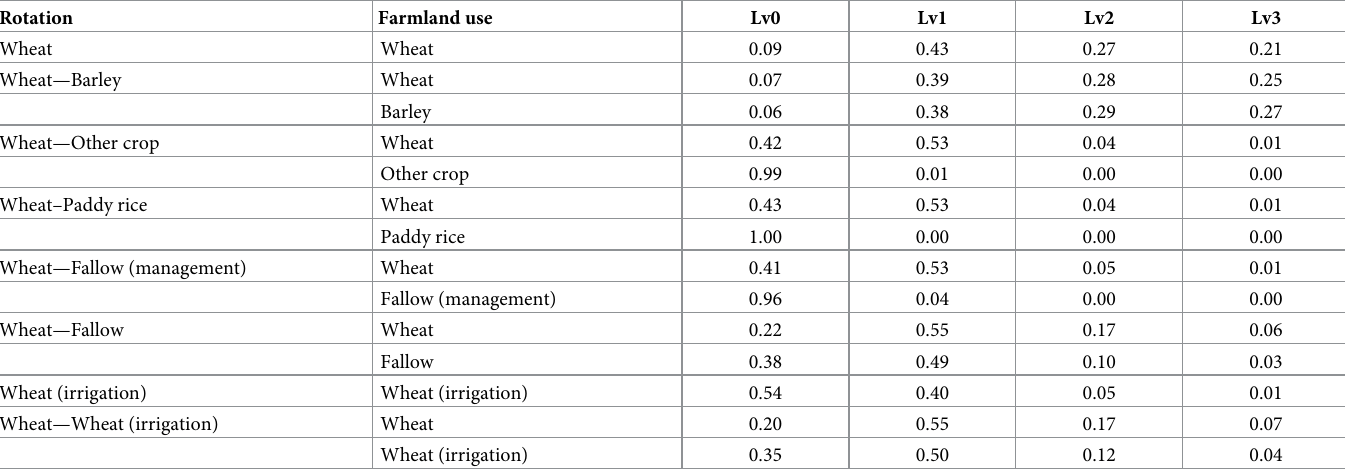
Table 3. Equilibrium probabilities of Avena fatua coverage under each rotation type.